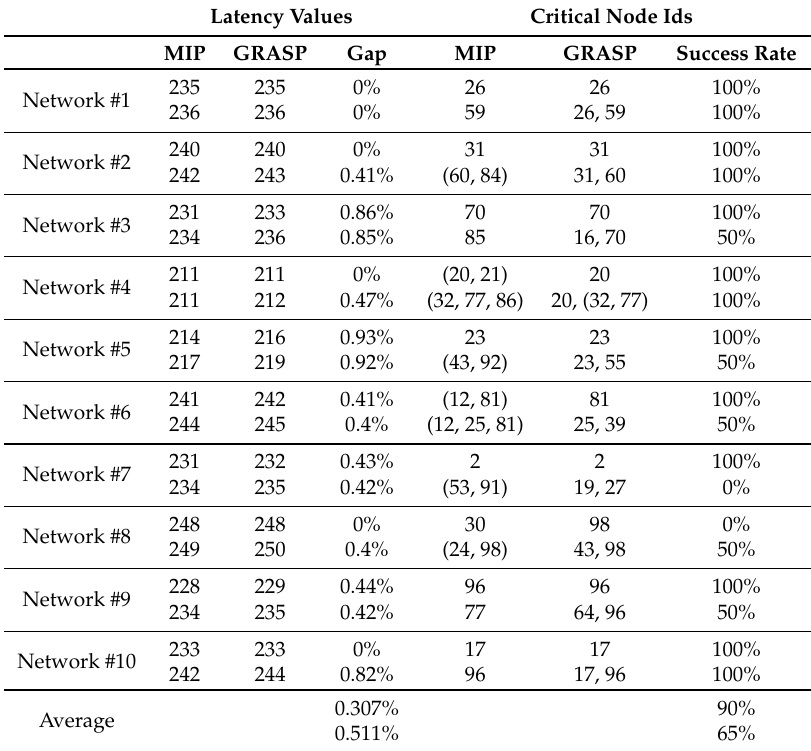
Table 8. Comparison between MIP and GRASP latency models. Nodes between parenthesis are interchangeable since they offer the same result when being